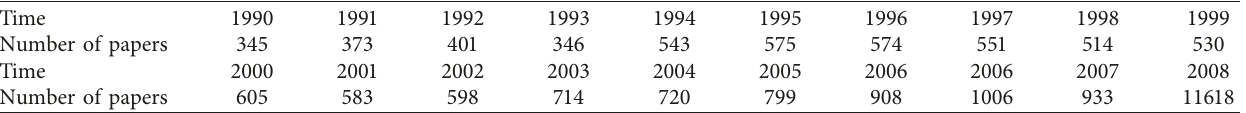
Table 7: The search outcomes of “fuzzy mathematics.”